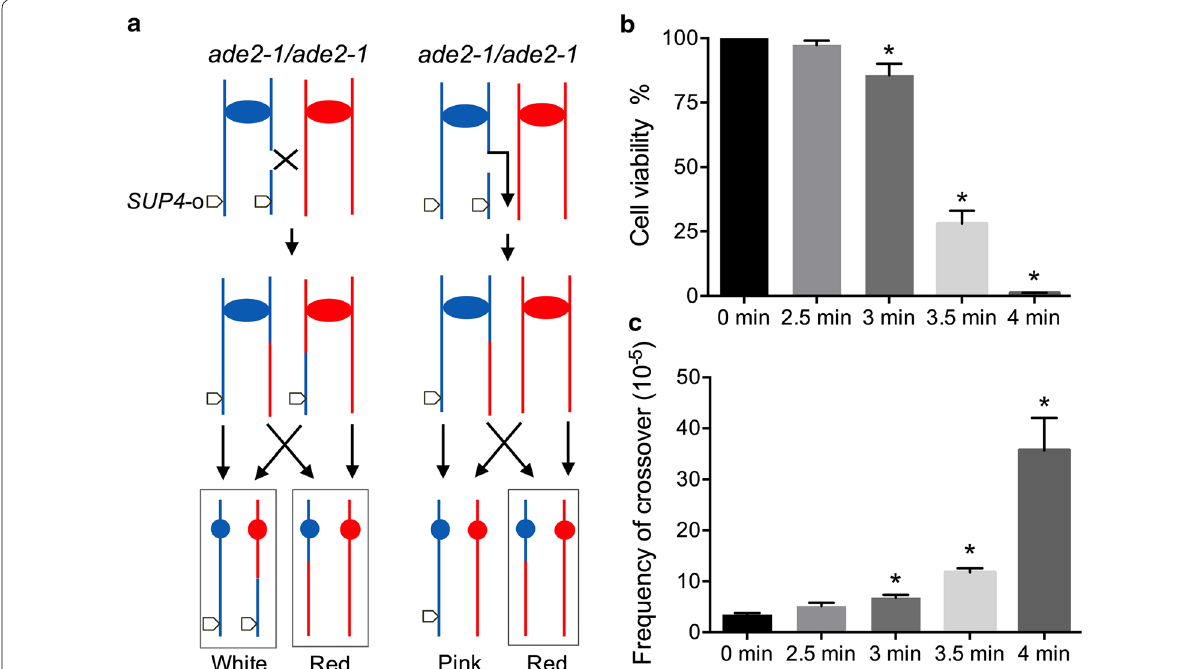
Fig. 1 Heat shock stimulates mitotic recombination in the yeast strain JSC25‑1. a A reciprocal crossover event on the right arm of chromosome IV would produce white/red‑sectored JSC25‑1 colonies. Alternatively, break‑induced replication (nonreciprocal crossover) would produce white/ pink‑ or red/pink‑sectored colonies. b Cell viability of the JSC25‑1 yeast strain after heat shock exposure (52 °C) for 2–4 min. c Reciprocal crossover frequency determined by calculating the red/white‑sectored colonies formed on YPD plates after heat shock. “*” indicates significant difference at the level of 0.01 using t